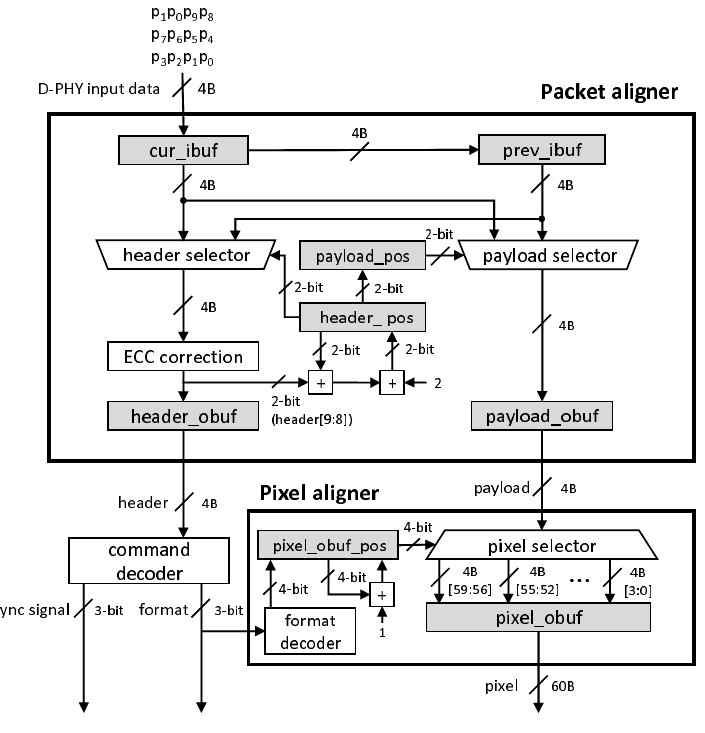
Figure 3. A baseline design. The gray boxes represent